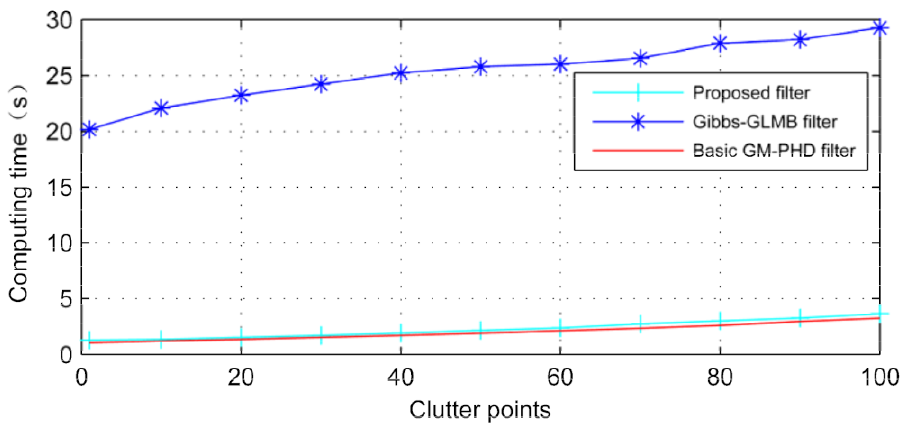
Figure 8. Computing times of different algorithms under various clutter rates for 250 sample runs ( p D , k =